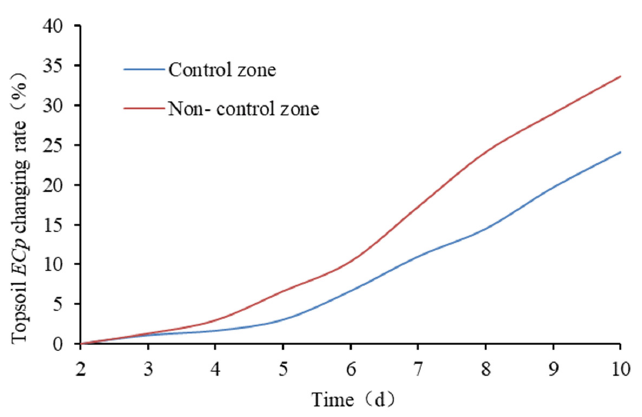
Figure 11. Change process of the topsoil EC p changing rates.